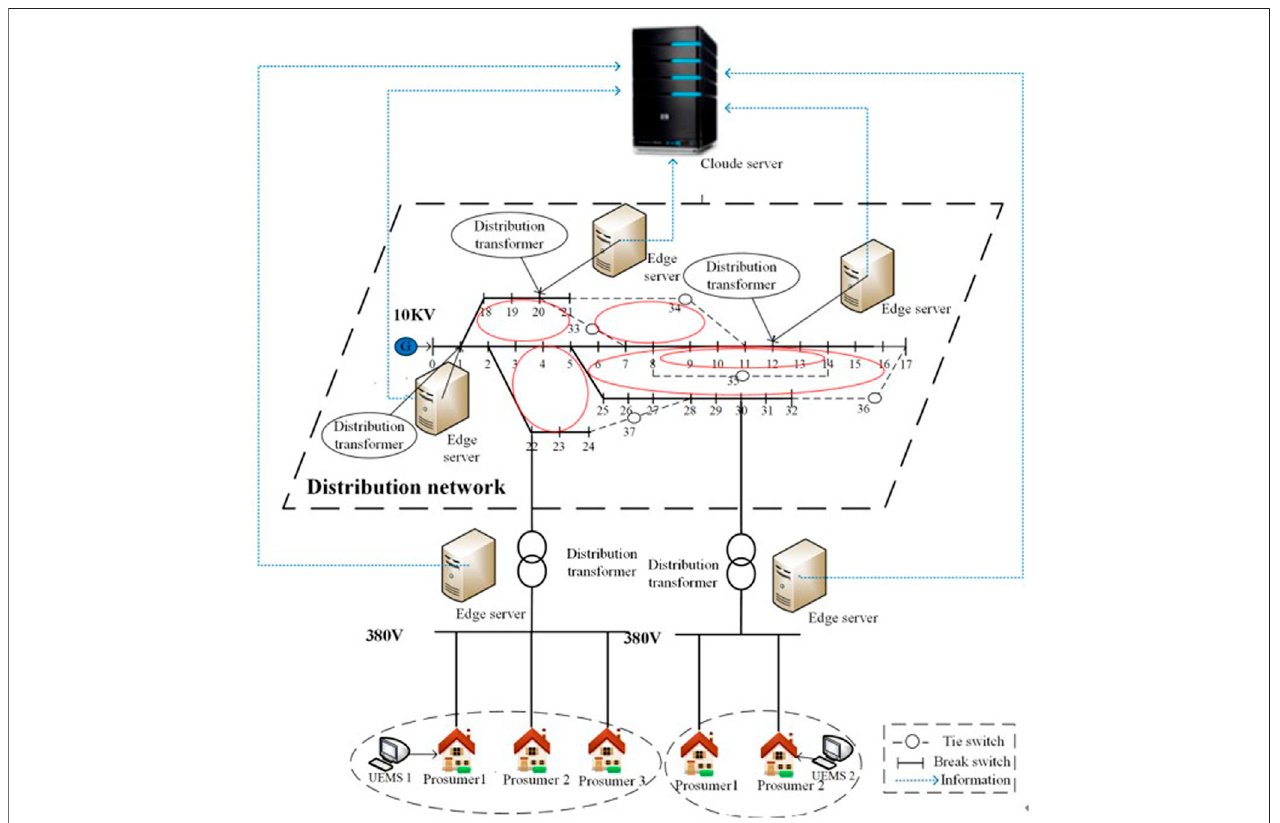
FIGURE 6 | IEEE 33-bus distribution system in the recon fi guration framework with fi ve DT accesses to fi ve buses, 60 prosumers classi fi ed into four categories, a CS, and fi ve ESs allocated.